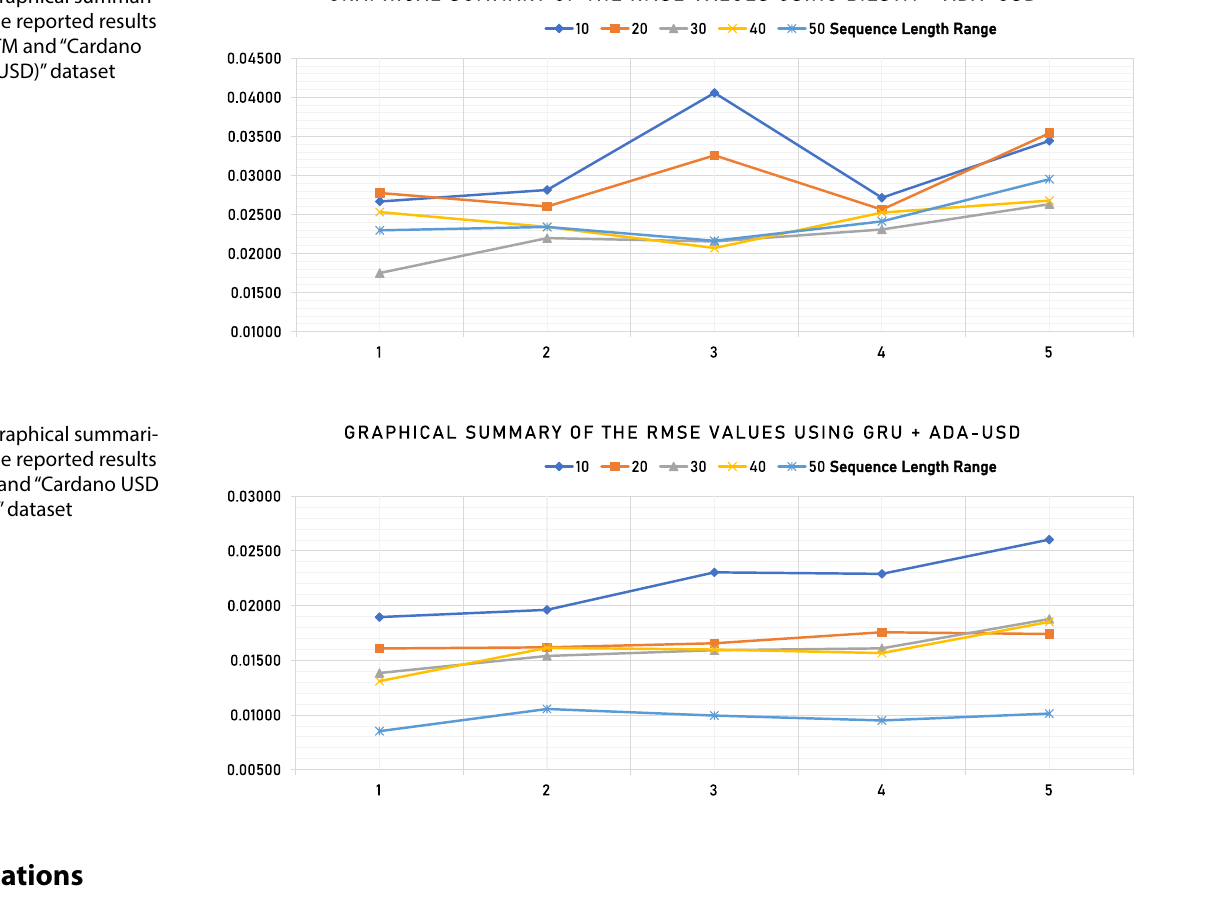
Fig. 12 A graphical summari- zation of the reported results using BiLSTM and “Cardano USD (ADA-USD)” dataset